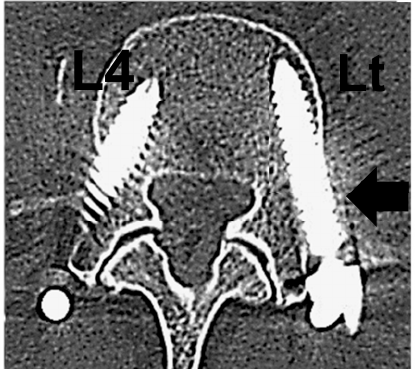
Table 1. Comparison of the baseline data between two groups.